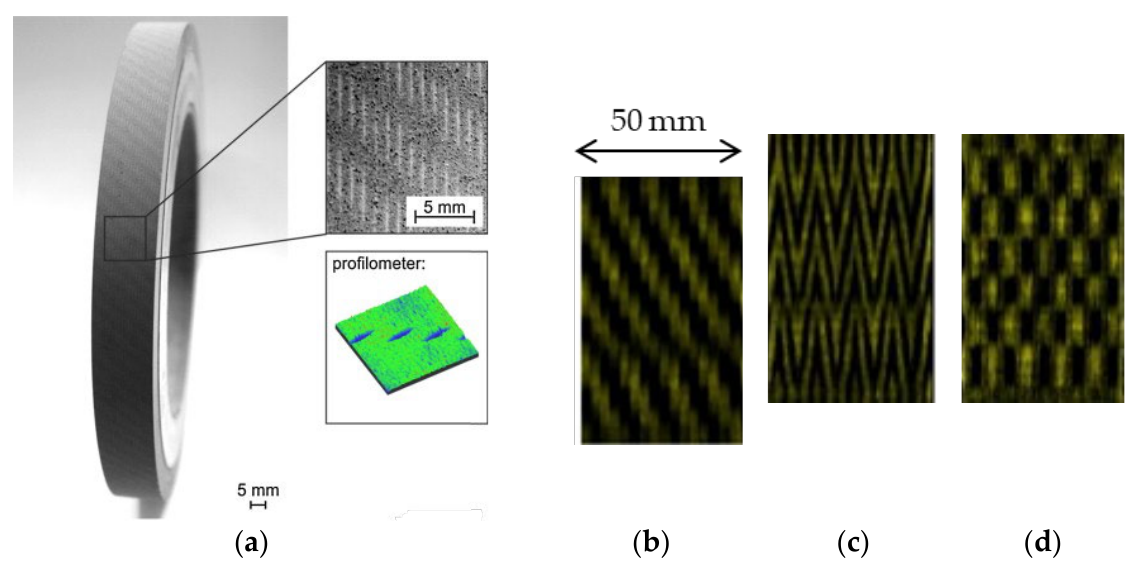
Figure 5. Machined grooves in ( a ) slit form [36], ( b ) helical form, ( c ) zigzag form, and ( d ) cross linear form [27].